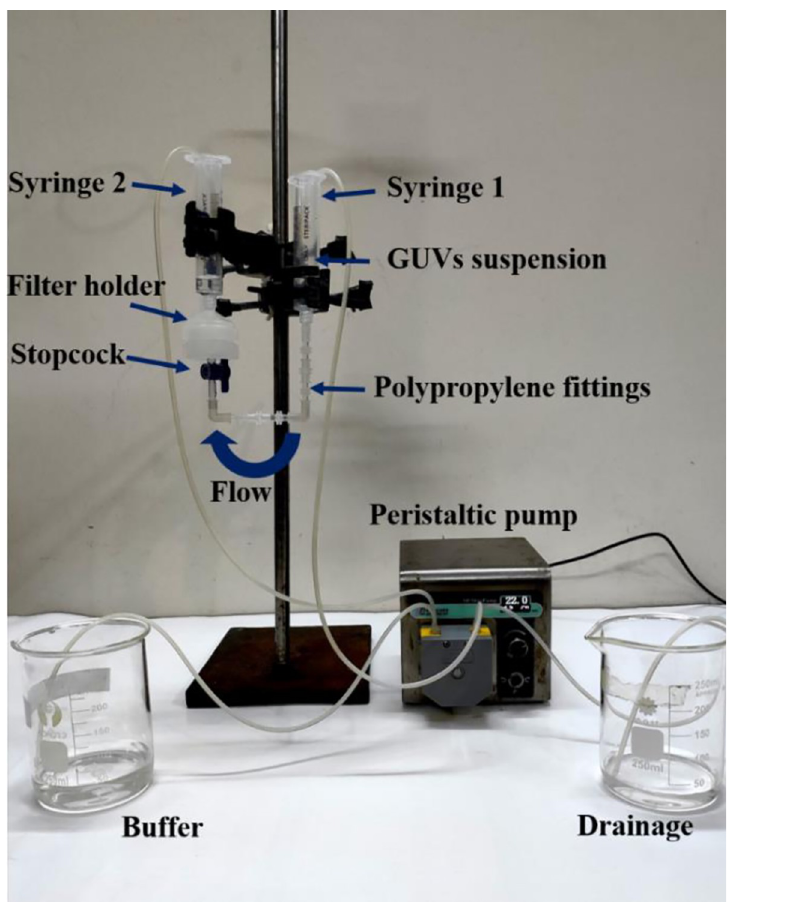
Fig 5. Experimental set-up of single filtration